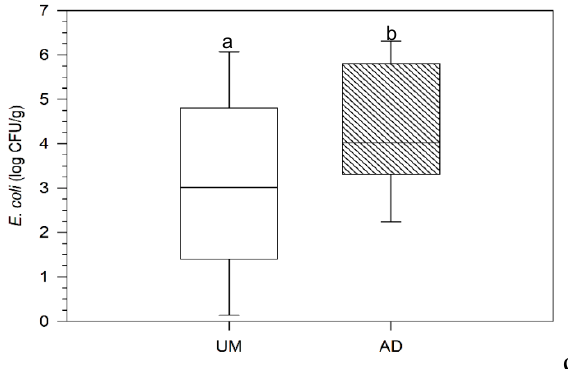
Figure 2. Variability of E. coli enumeration on UM and AD samples (Results marked with the same letters are statistically similar (Tukey HSD test with p < 0.05)).